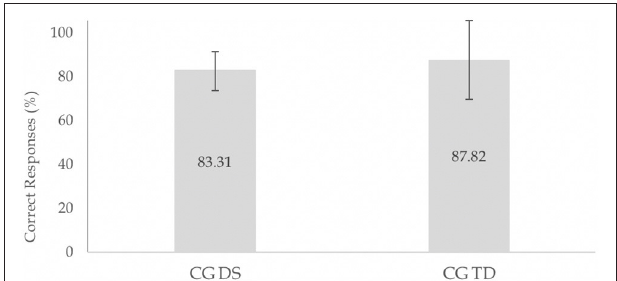
FIGURE 2 | Mean percentage of subjunctive comprehension in Cypriot Greek (bilectal) children and adolescents with DS and typical language development.